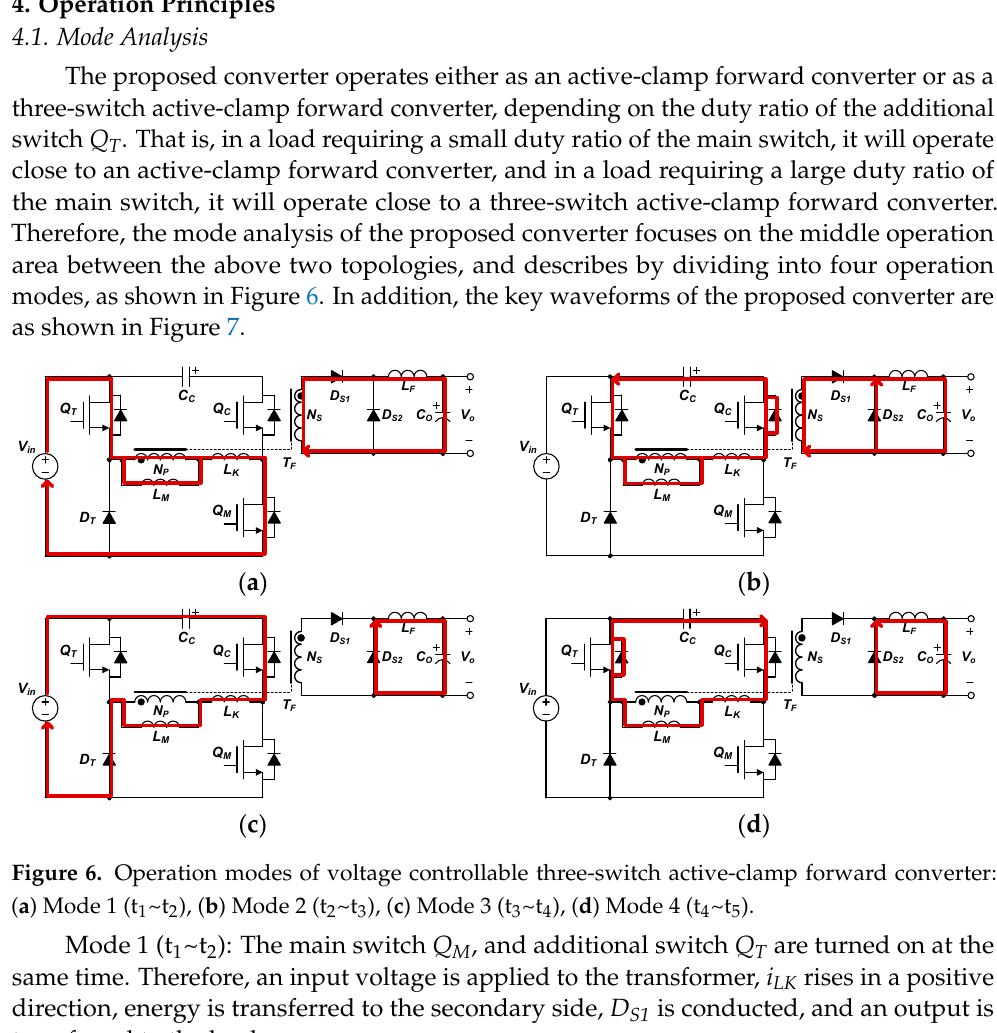
Figure 5. Voltage stress control circuit applied to the proposed converter.